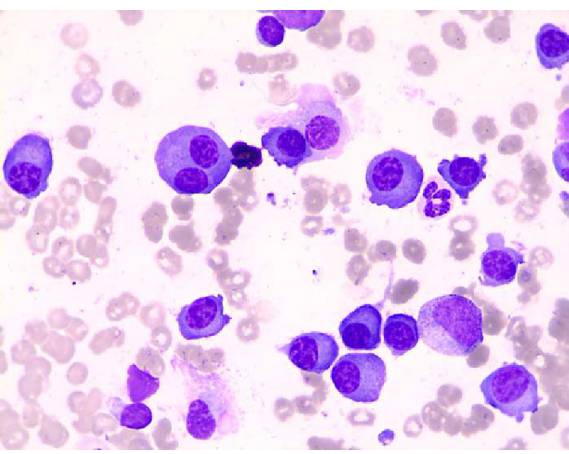
Figure 2: The bone marrow image showed an MM bone marrow change ( Wright stain )